Question: Provide a one-line summary of what is displayed.
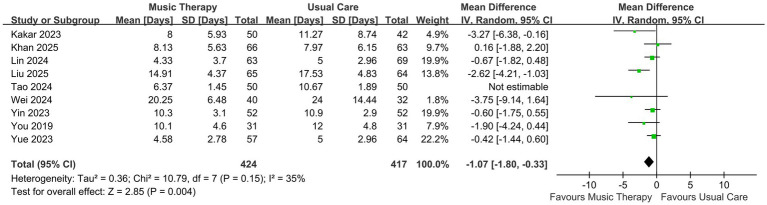
Answer: Forest plot for intensive care unit (ICU) length of stay after sensitivity analysis.